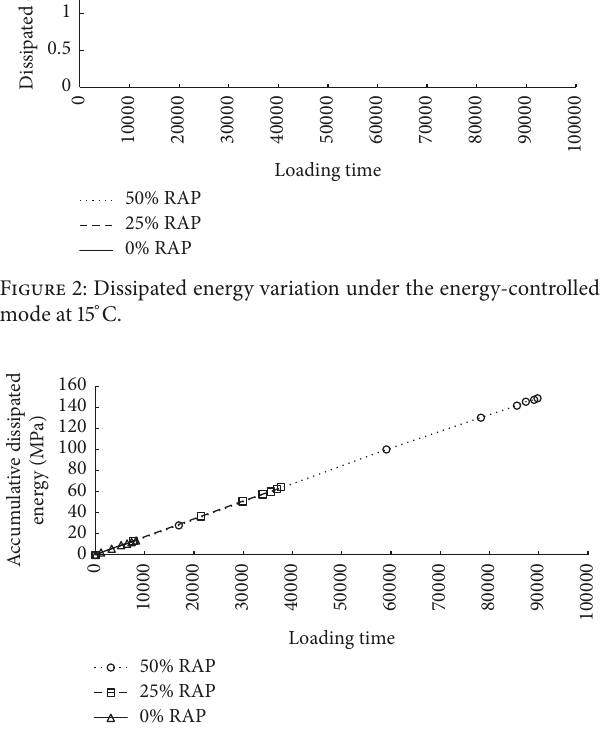
Figure 3: Accumulative dissipated energy variation under the ener- gy-controlled mode at 15 ∘